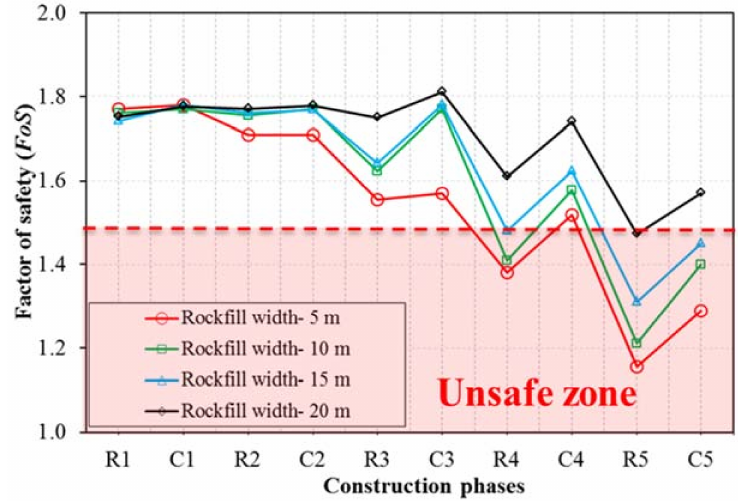
Figure 6. Rockfill width optimization based on slope stability analysis (filling rate of 5.0